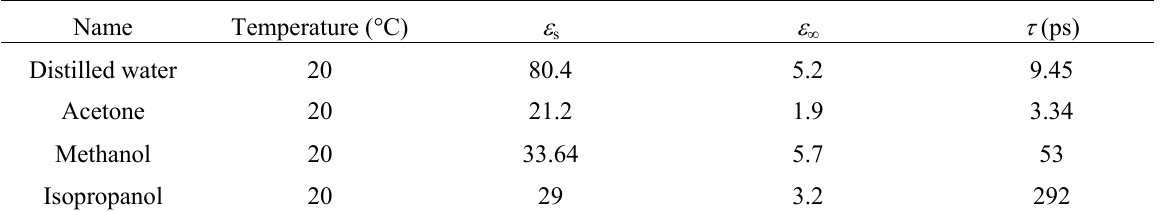
Table 2. Parameters of Debye model of the applied reference liquids